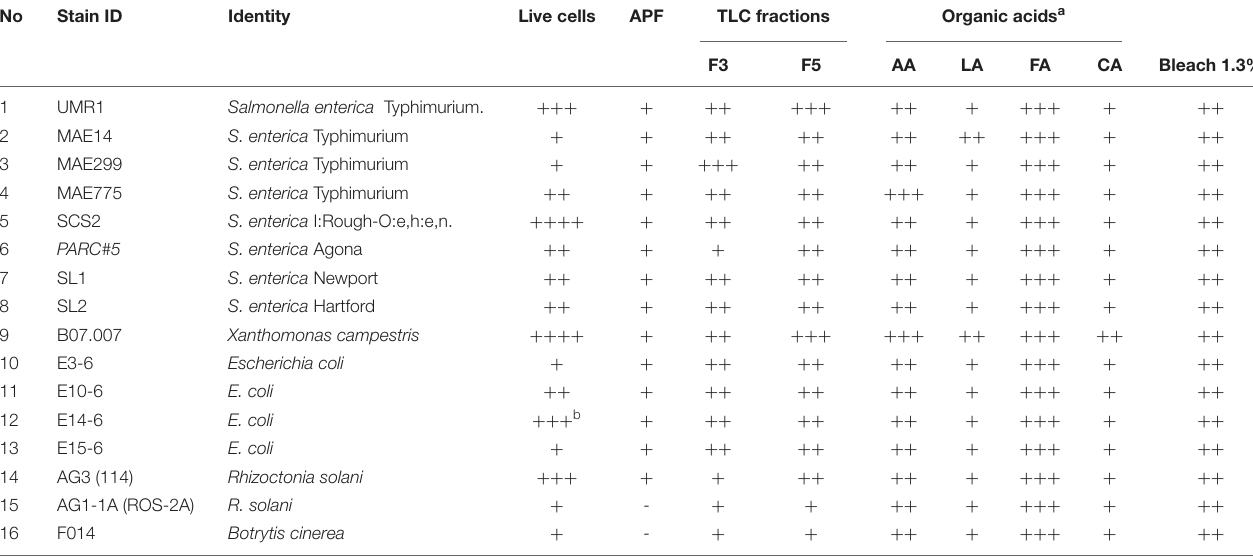
TABLE 3 | Microbial activity of the B. methylotrophicus OB9 fractions, organic acids and bleach against various pathogenic bacteria and fungal strains. No Stain ID Identity Live cells APF TLC fractions Organic acids